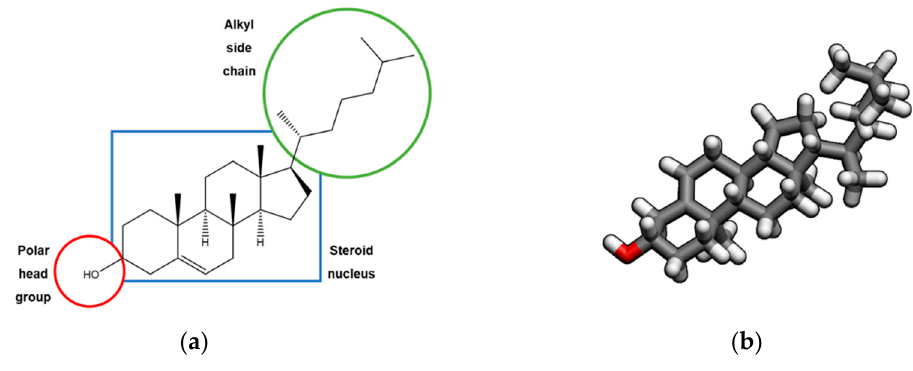
Figure 1. ( a ) 2D; and ( b ) 3D structures of the cholesterol molecule.